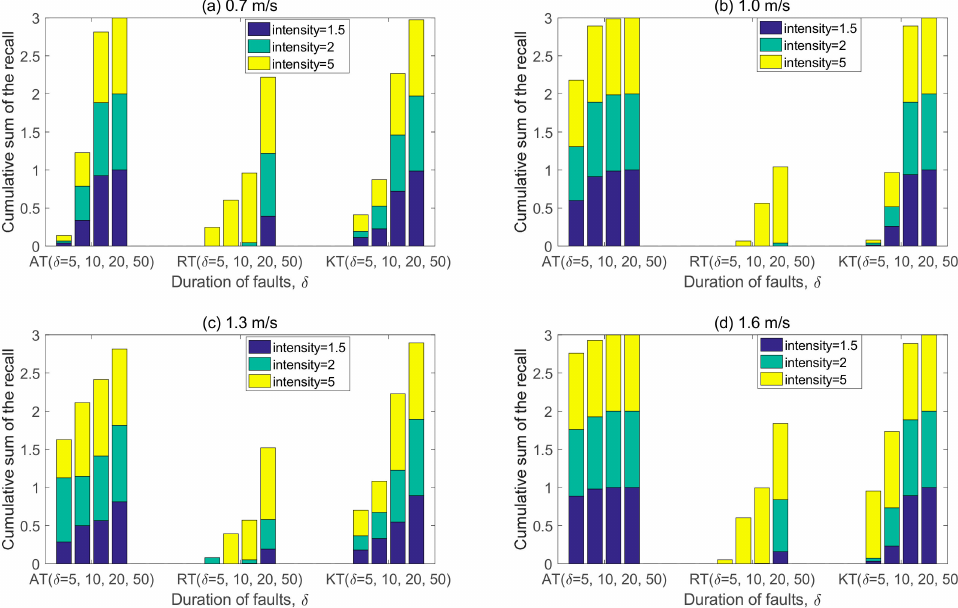
Figure 5. Recall according to each intensity as a function of constant fault duration: ( a ) Cumulative sum of the recall at 0.7 m/s of Jackal UGV; ( b ) Cumulative sum of the recall at 1.0 m/s; ( c ) Cumulative sum of the recall at 1.3 m/s; ( d ) Cumulative sum of the recall at 1.6